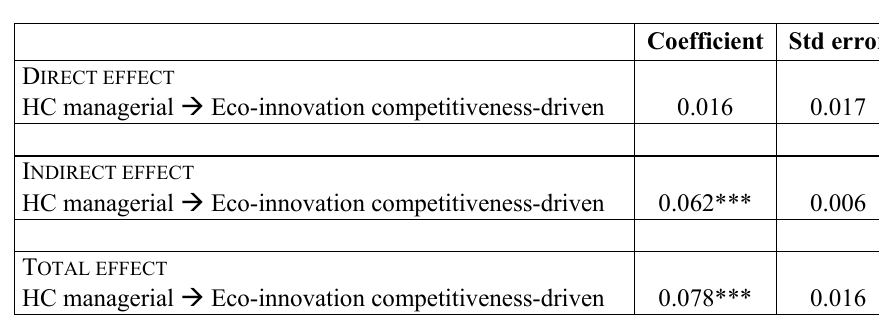
Table 6: Direct, Indirect, and Total Effects of HC Strategic on Eco-innovation